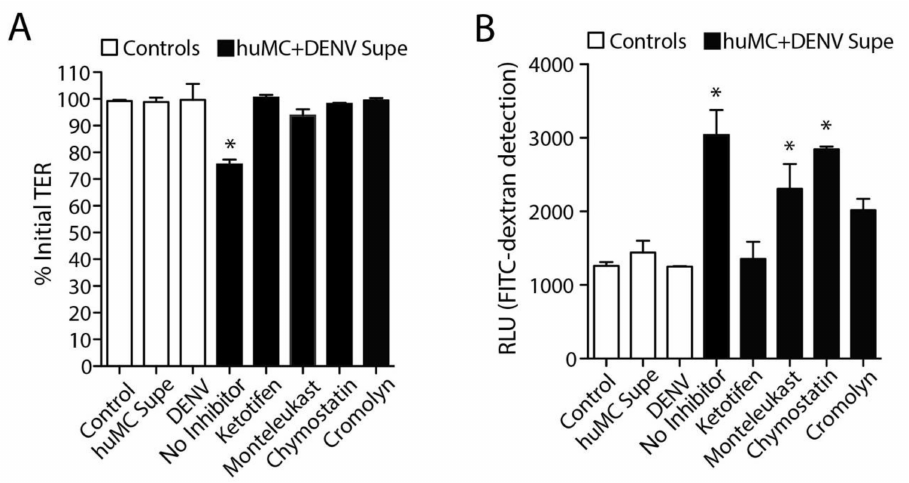
Figure 5. MC-stabilizing drugs block permeability of huMEC monolayers. ( A ) The TER was measured across huMEC monolayers 24 h after control treatments, treatment with the supernatants of DENV-activated MCs, or supernatants of HuMCs activated by DENV in the presence of MC modulating drugs. * Indicates a significant decrease over control, determined by 1-way ANOVA ( p < 0.05). The average baseline TEER in control cells was approximately 220 Ω × cm 2 . ( B ) Corresponding measurements of FITC-dextran flux across huMEC monolayers were obtained 48 h after treatment. * Indicates a significant increase over control, determined by 1-way ANOVA ( p <